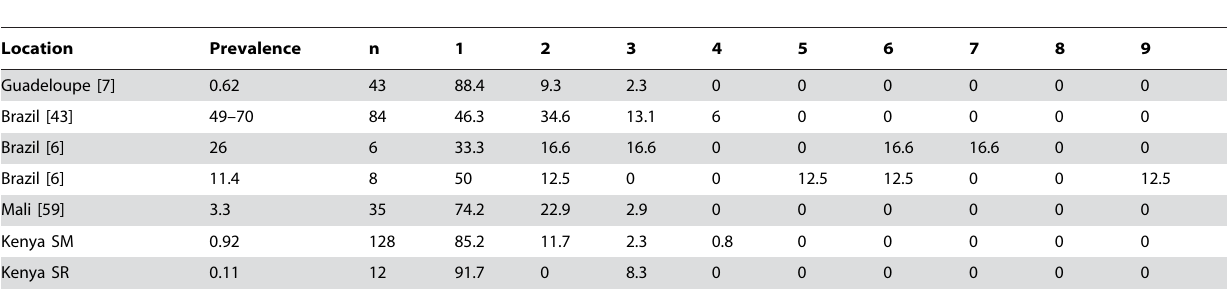
Table 3. Percentage of snails infected with 1–9 genotypes of schistosome parasites from this study and previous studies (n indicates snail sample